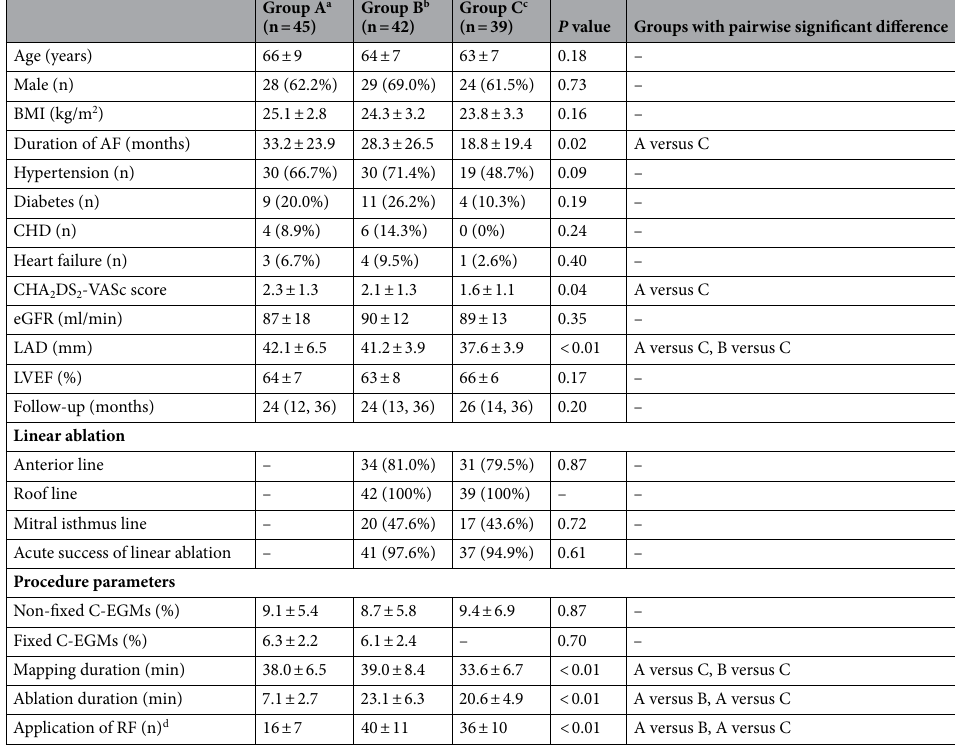
Table 2. Characteristics of persistent AF patients. a Persistent AF patients with fixed-C-EGMs and received fixed-C-EGMs ablation were classified as Group A. b Persistent AF patients with fixed-C-EGMs and received linear ablation were classified as Group B. c Persistent AF patients without fixed-C-EGMs and received linear ablation were classified as Group C. d Excluding circumferential pulmonary vein isolation. AF, atrial fibrillation; BMI, body mass index; C-EGMs, complex electrograms during sinus rhythm; CHD, coronary heart disease; eGFR, estimated glomerular filtration rate; LAD, left atrial dimension; LVEF, left ventricular ejection fraction; RF,